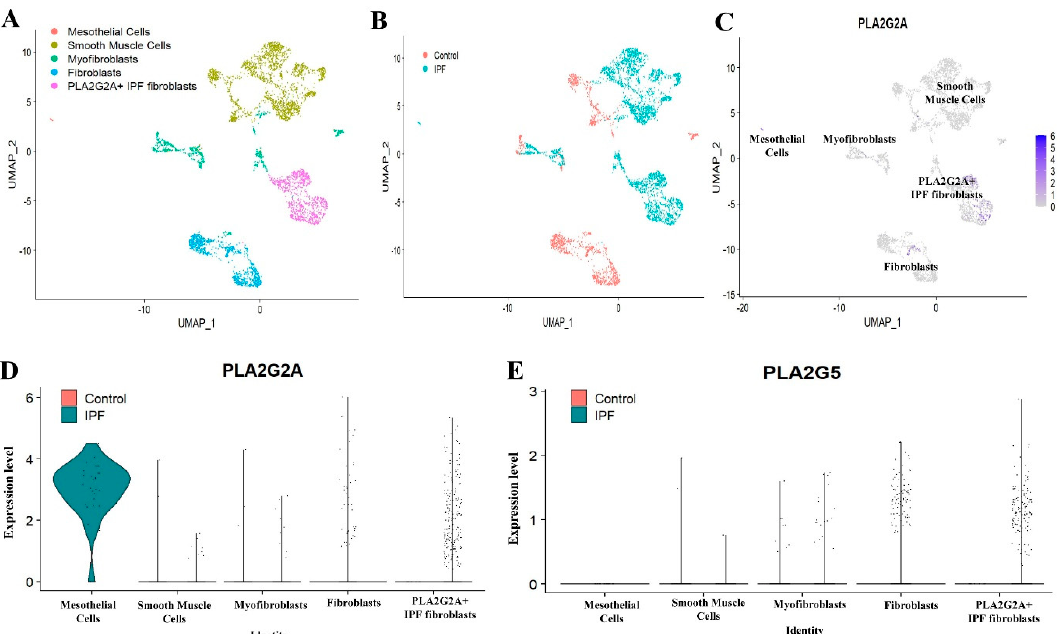
Figure 3. Analyzing expression of PLA2G2A and PLA2G5 in mesenchymal cells in data set B (GSE132771). ( A ) UMAP visualization of mesenchymal cells, various clusters displaying different types of mesenchymal cells. ( B ) UMAP plot showing cells, colored by their origin either from Control or IPF patients. ( C ) Feature plot displaying expression of PLA2G2A. ( D ) Violin plot showing expression of PLA2G2A in various subclusters of mesenchymal cells. ( E ) Violin plot of expression of PLA2G5 in mesenchymal cells.